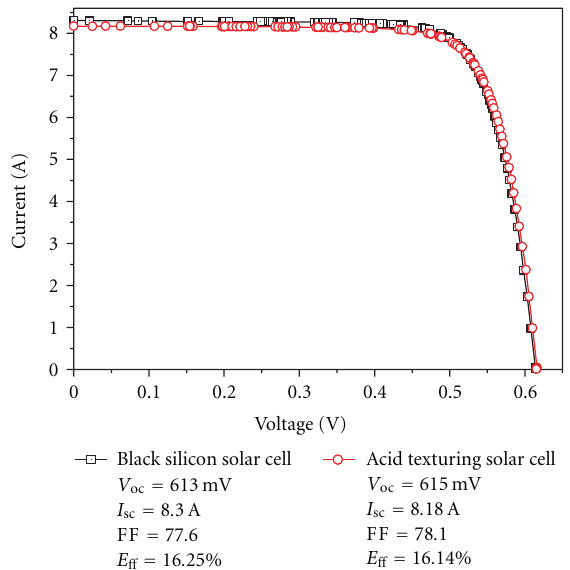
Figure 9: The current-voltage ( I - V ) characteristics of black silicon solar cell compared with acid-textured Si solar